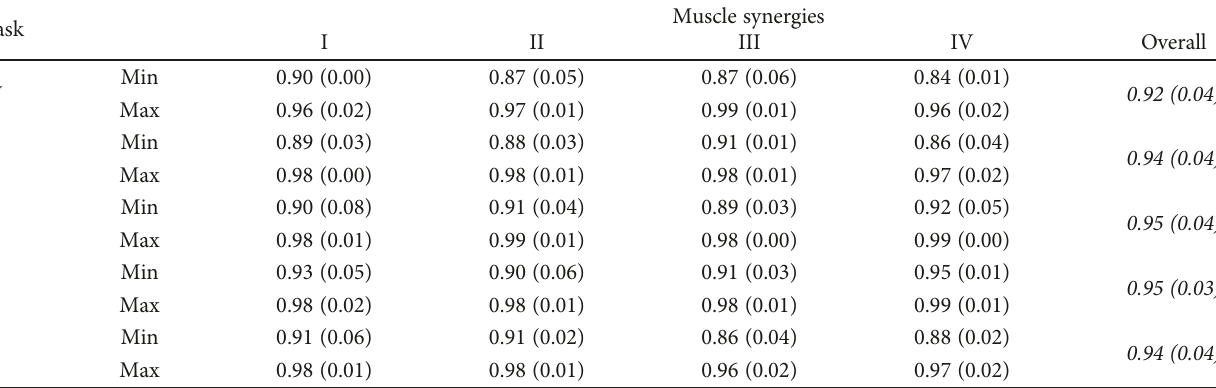
Table 7: Maximum and minimum and relative standard deviation (SD) of the WB cos considering all the synergies together are reported in italic.